Question: Briefly state, in one sentence, what is plotted here.
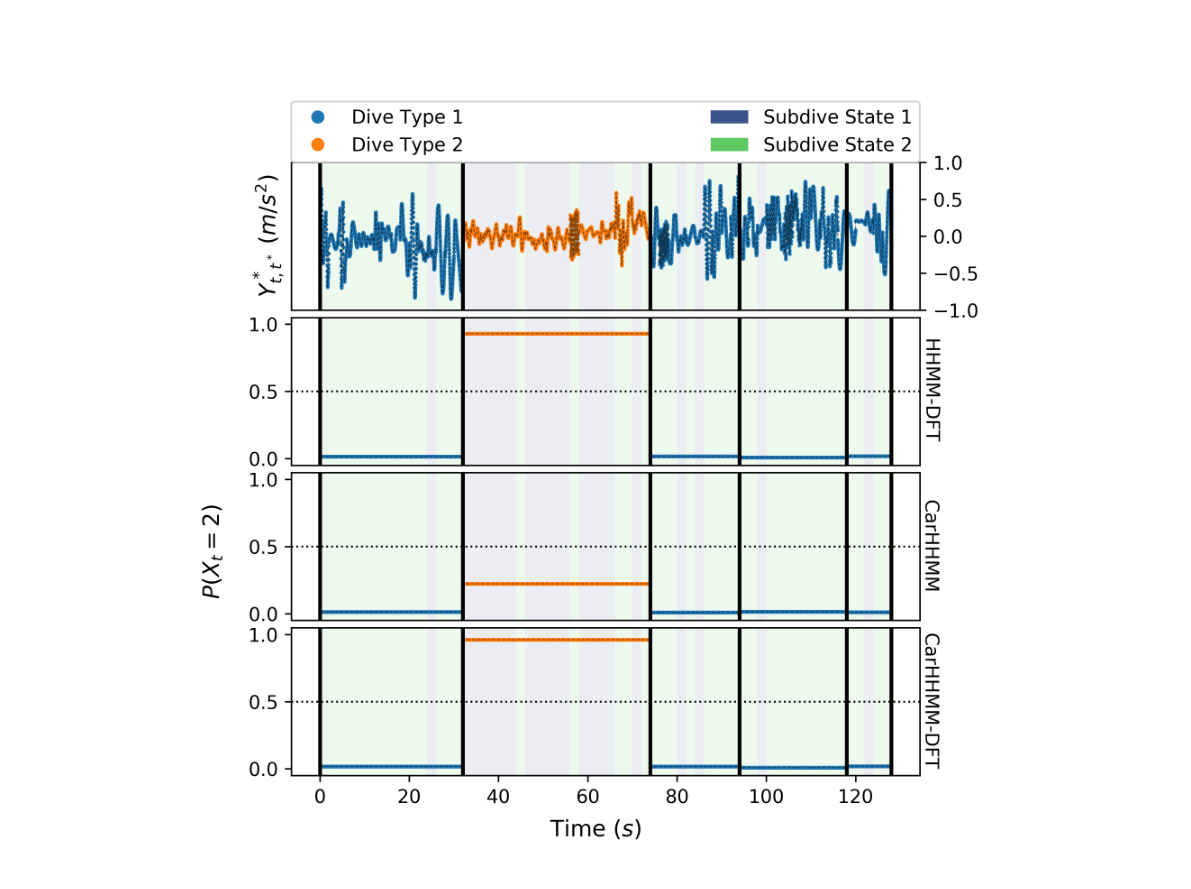
Answer: Estimated probabilities that each dive is of type 2 for ﬁve selected dives of a simulated data set of killer whale dive behaviour. Each panel is partitioned into dives by vertical black lines. The colour of the curve corresponds to the true dive type while the colour of the background corresponds to the true subdive state. The CarHMM-DFT is omitted because it assumes that there is only one dive type.